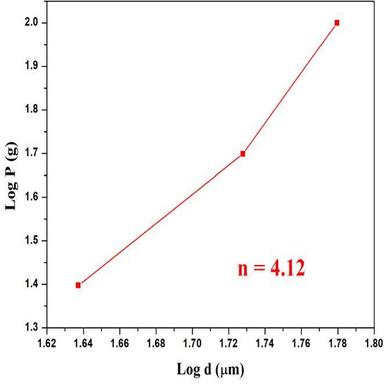
Variation of log d verses log P for UGA crystal.